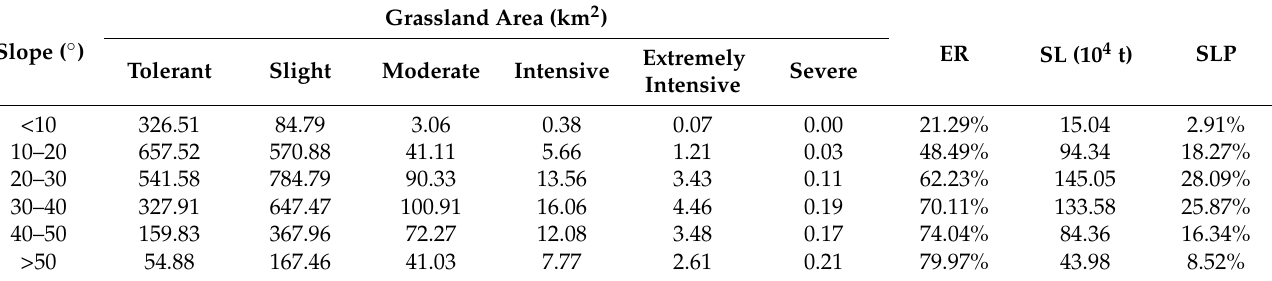
Table 6. Soil erosion status of grasslands between different slope